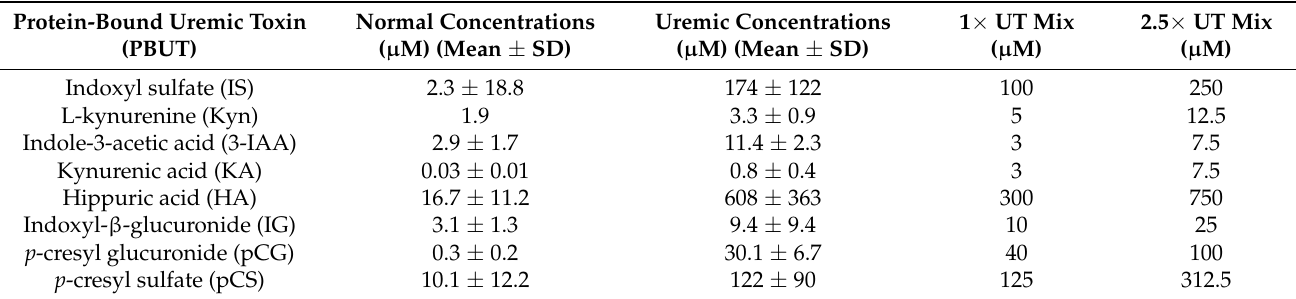
Table 1. Concentrations of selected protein-bound uremic toxins (PBUTs) in healthy individuals, kidney disease patients and as applied within UT mixture in the present study 1